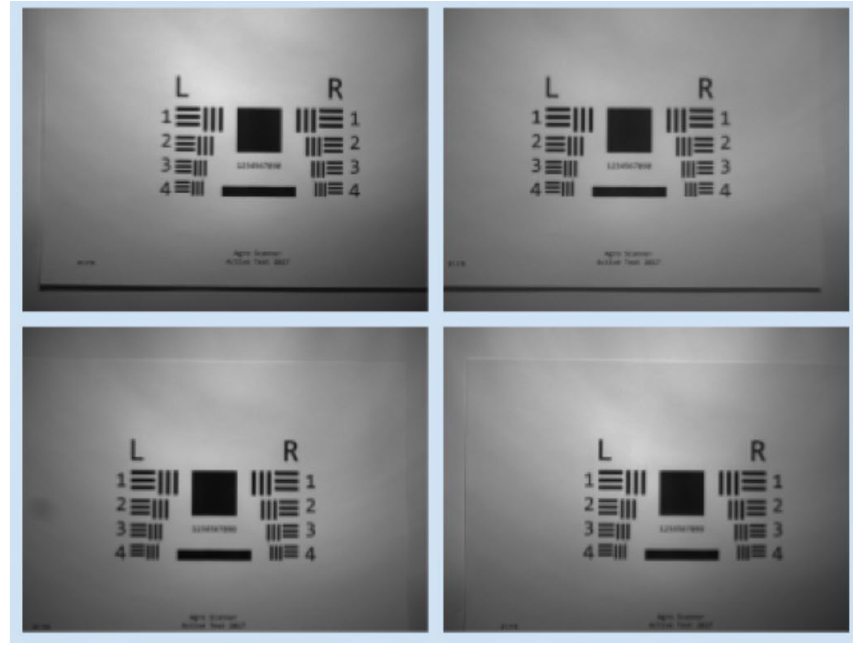
Figure 2. Agroscanner camera geometry calibration on carbon-based (laser printout) calibration plate. A carbon-based calibration plate provides similar images for every spectral image from all cameras. Each plant was photographed from different perspectives, and the total number of images of one object equaled 30, each of them comprising 4 corresponding pictures from each camera (captured at 470, 550, 640 and 850 nm wavelength). After measurement completion, recorded data were automatically sent to Active Text servers. Each measurement consists of 4 greyscale images (one for each wavelength) of 1600 × 1200 pixels (Figure